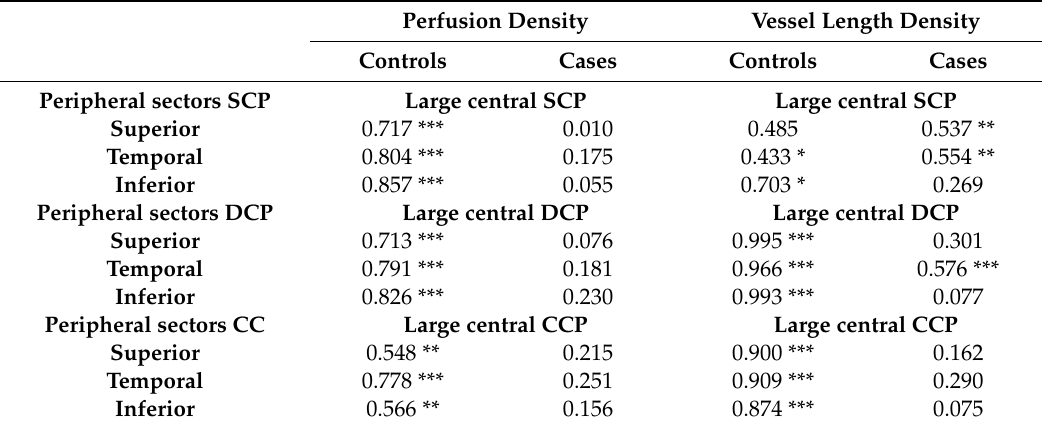
Table 6. Pearson’s correlation coe ffi cients among central and peripheral sectors of perfusion density and vessel length density.